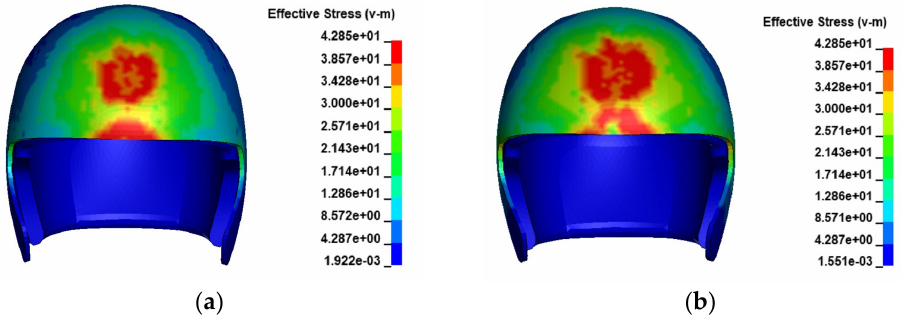
Figure 11. Stress distribution on the shell component at 27 kph. ( a ) Impact angle: 30 degrees; ( b ) impact angle: 60 degrees.